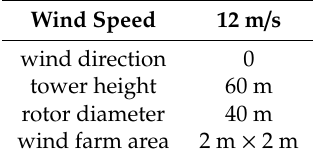
Table 1. Technical characteristics.